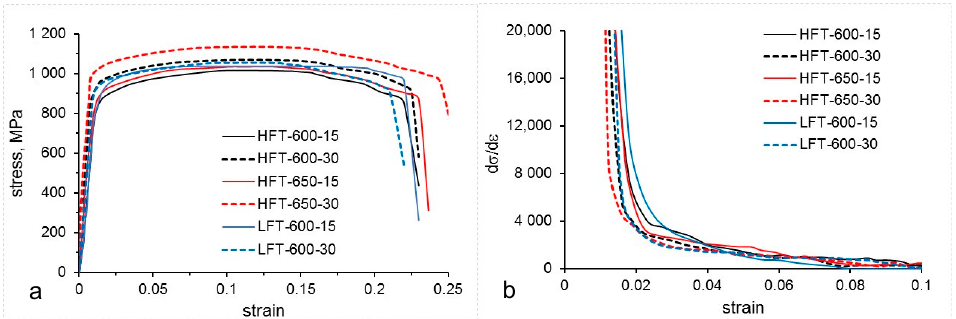
Figure 9. ( a ) Stress–strain curves and ( b ) work hardening rate for the studied steel.